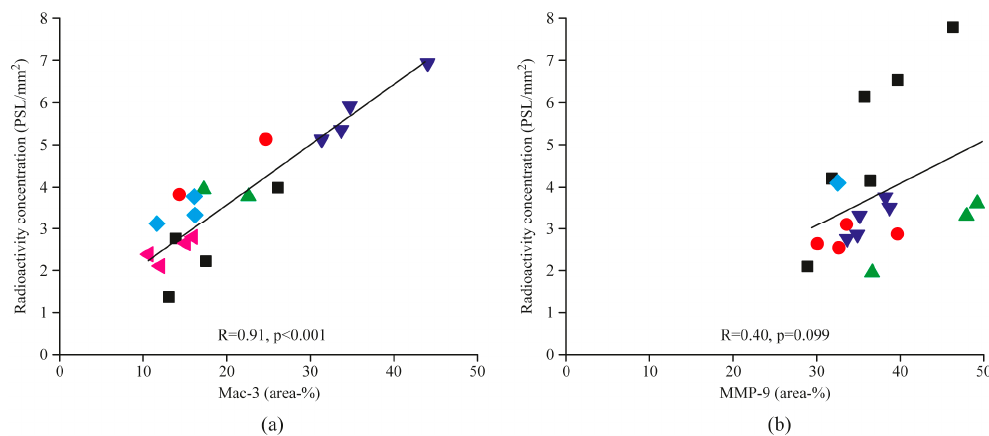
Figure 4. Scatter plots show correlations between areal percentages of Mac-3-positive macrophages ( a ), or MMP-9 ( b ), and corresponding [ 68 Ga]Ga-DOTA-TCTP-1 uptake in the atherosclerotic plaques. Each symbol type represents plaques from the same animal. R , Pearson’s rank correlation coefficient; PSL , photostimulated